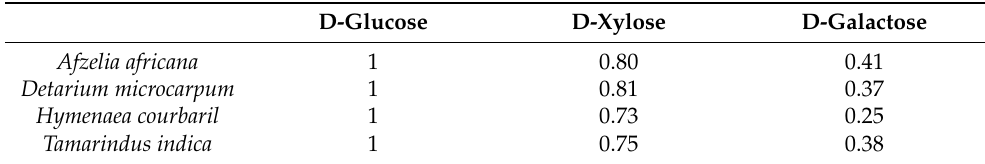
Table 1. Glucose/xylose/galactose molar ratios. (Adapted from [18], with permission from The Society of Fiber Science and Technology, Japan.) D-Glucose D-Xylose D-Galactose Afzelia